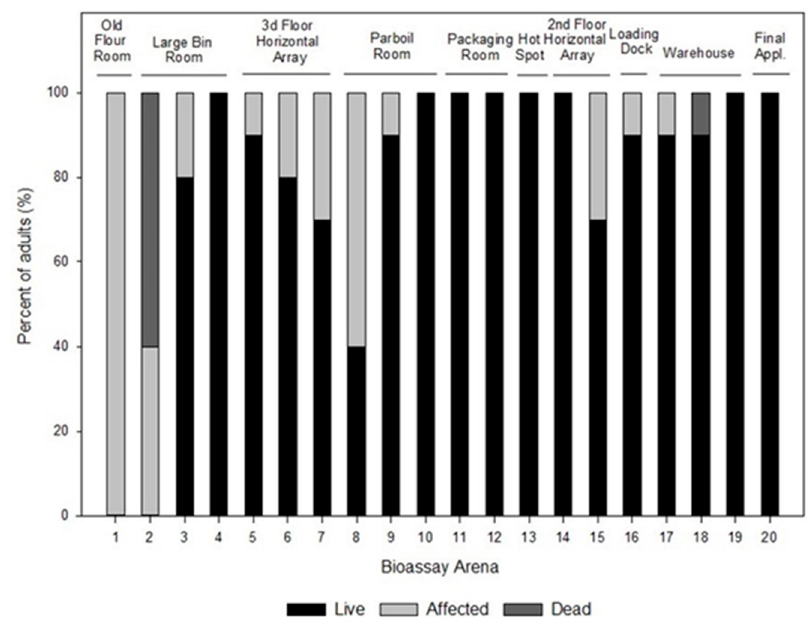
Figure 4. The percent of live vs. affected vs. dead adult T. confusum one week post aerosol application at each bioassay arena locations.